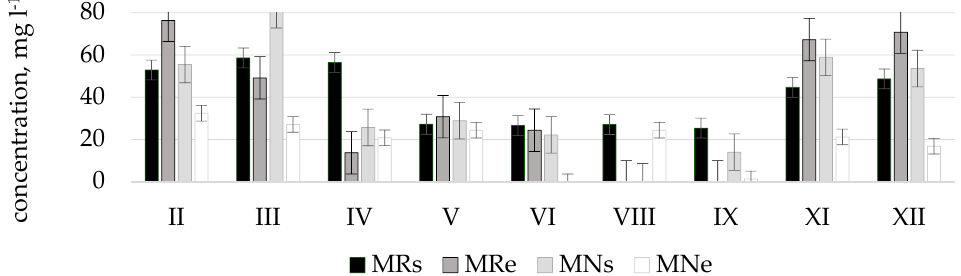
Figure 3. Nitrate concentrations ( NO (cid:2871)(cid:2879) ) in natural (N) and regulated (R) stretches of M ė kla stream.